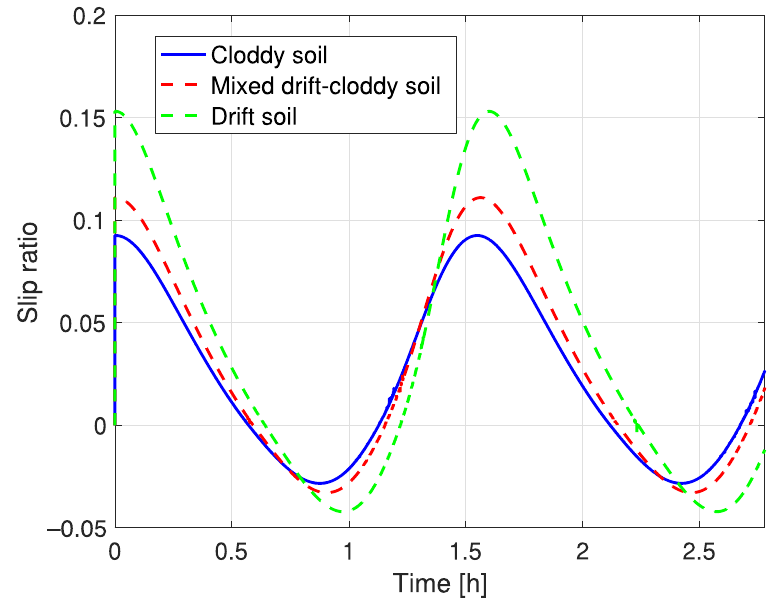
Figure 5. Rover’s speed on ( a ) cloddy soil, ( b ) mixed drift-cloddy soil and ( c ) drift soil on a 10° slope with constant steering angle 𝛿 = 4° .